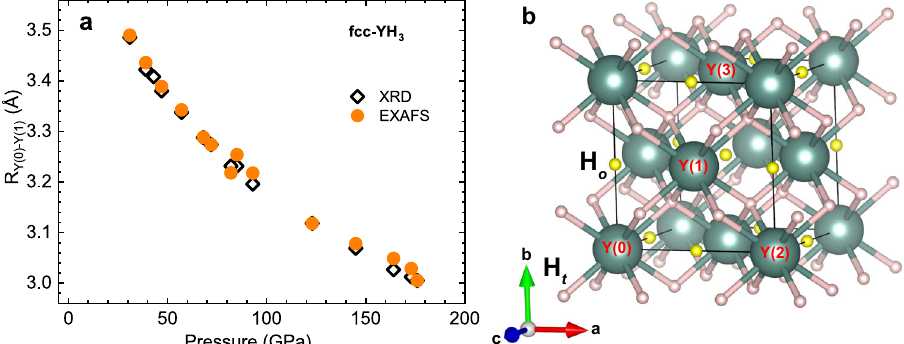
ffiffiffi p 2 , ( a is the lattice parameter) for fcc YH 3